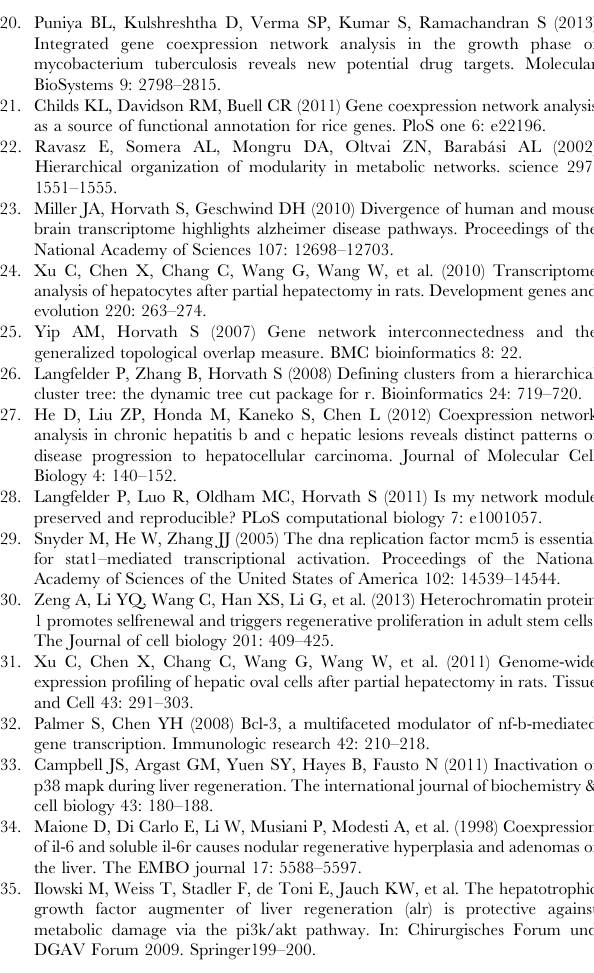
Table S1 Module composition based WGCNA in PH group and SO group.